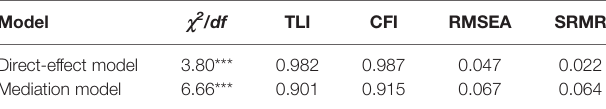
TABLE 2 | Fit indices of the two models.